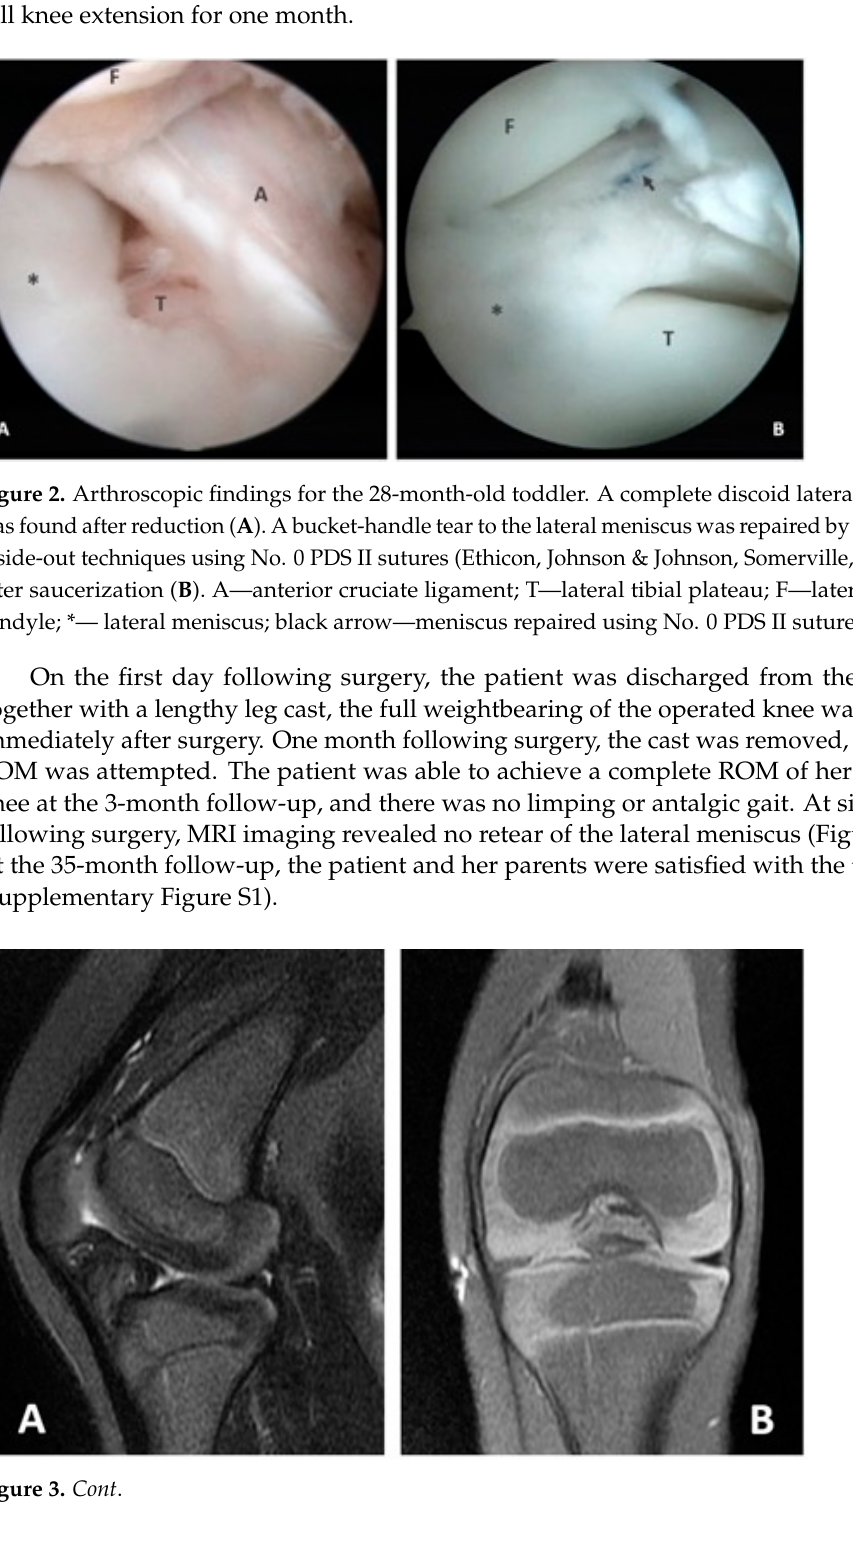
Figure 3. MRI of the affected knees for the two cases at the 6-month follow-up. ( A ) coronal and ( B ) sagittal planes for the case of the 28-month girl. ( C ) coronal and ( D ) sagittal planes for the case of the 5-year-old boy. A triangular lateral meniscus without a retear was found in both cases. MRI— magnetic resonance imaging. 2.2. Case 2 The second case, a 5-year-old boy, was healthy before visiting our clinic. Pain and difficulty fully extending the right knee manifested about six months after a twisting in- jury. The ROM of his right knee ranged from 5° to 110°. A physical examination revealed no local symptoms of infection or instability and no palpable lumps in the affected knee. MRI revealed an increased thickness and flattening of the lateral meniscus, a loss of the natural bow-tie configuration, and a peripheral tear over the posterior horn, which sig- naled that this patient had a complete discoid lateral meniscus with a bucket handle tear (Figure 1C, D). The same treatment as that of case 1 was applied to this patient. Following reduction, a full discoid meniscus was discovered, and he subsequently received saucerization. Due to instability during knee flexion of more than 60° following saucerization, the patient